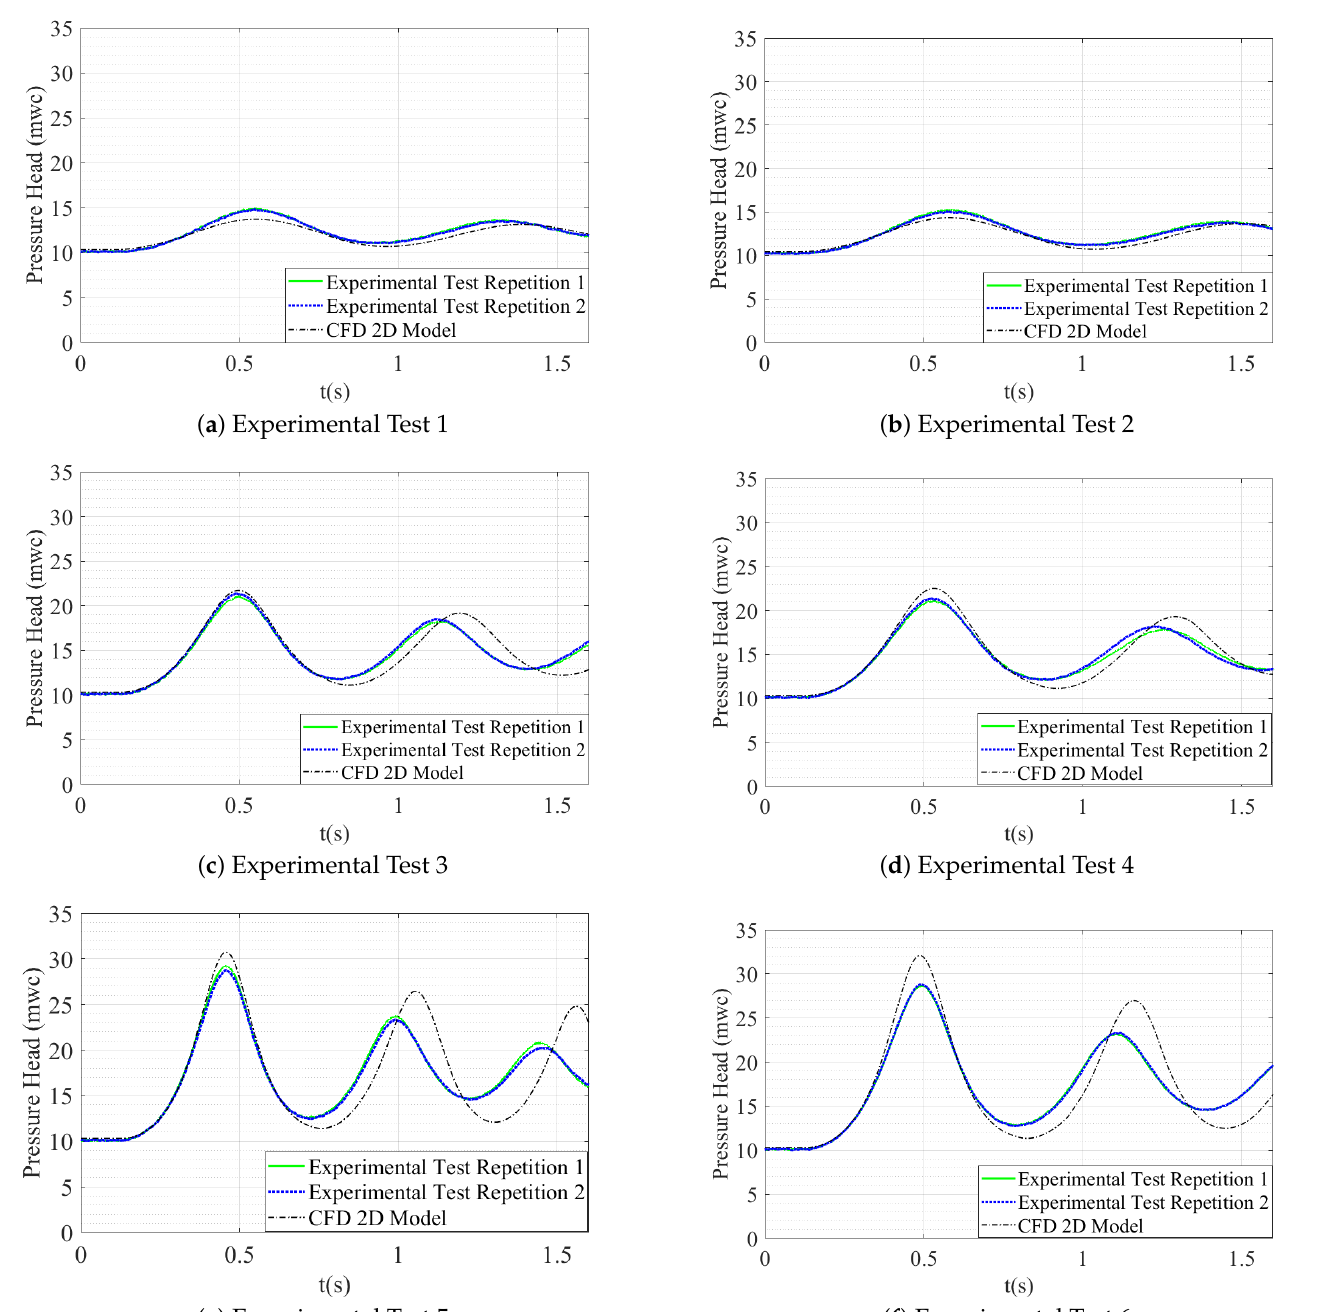
Figure 4. Comparison between the 2D CFD model and experimental